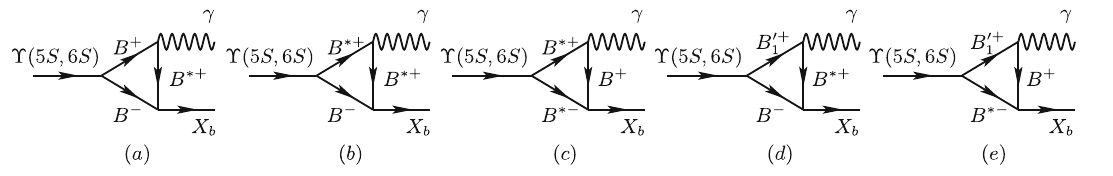
Fig. 1 Feynman diagrams for X b production in ϒ( 5 S , 6 S ) → γ X b under the B ¯ B ∗ meson loop effects